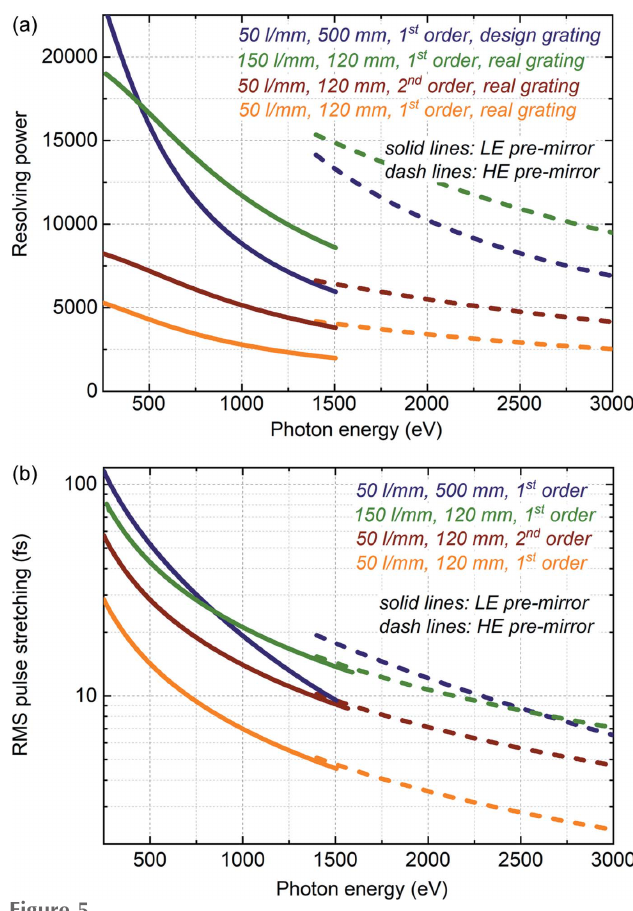
Figure 5 Monochromator performance. ( a ) Analytically estimated resolving power and ( b ) pulse stretching due to the grating for the 50 l mm (cid:2) 1 500 mm-long designed grating operating in first diffraction order, for the 50 l mm (cid:2) 1 120 mm-long installed grating operating in first and second diffraction orders, and for the 150 l mm (cid:2) 1 120 mm-long installed grating operating in first diffraction